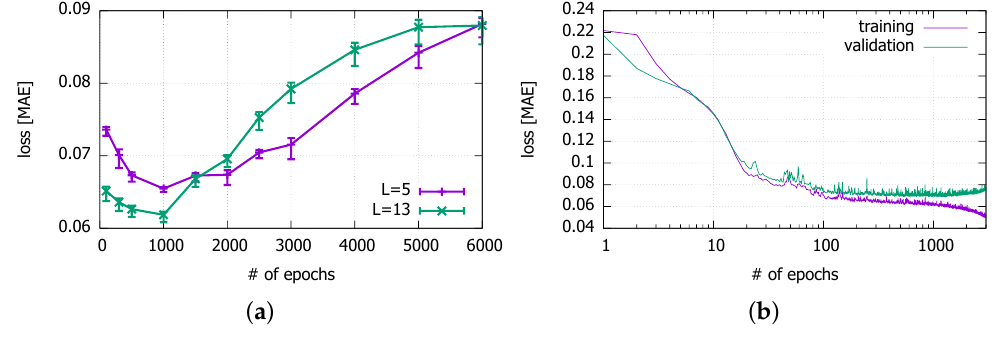
Figure 13. Impact of epochs on errors. ( a ) by trial-and-error (with 95% confidence interval); ( b ) by identifying where the performance against the validation data set begins to worsen—the early stopping criterion (for L =